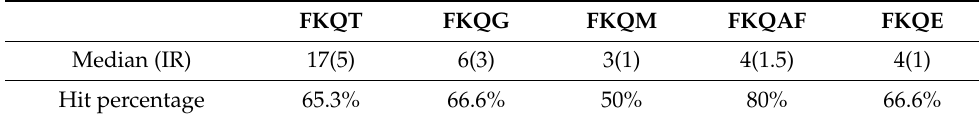
Table 6. Total score and by component of the